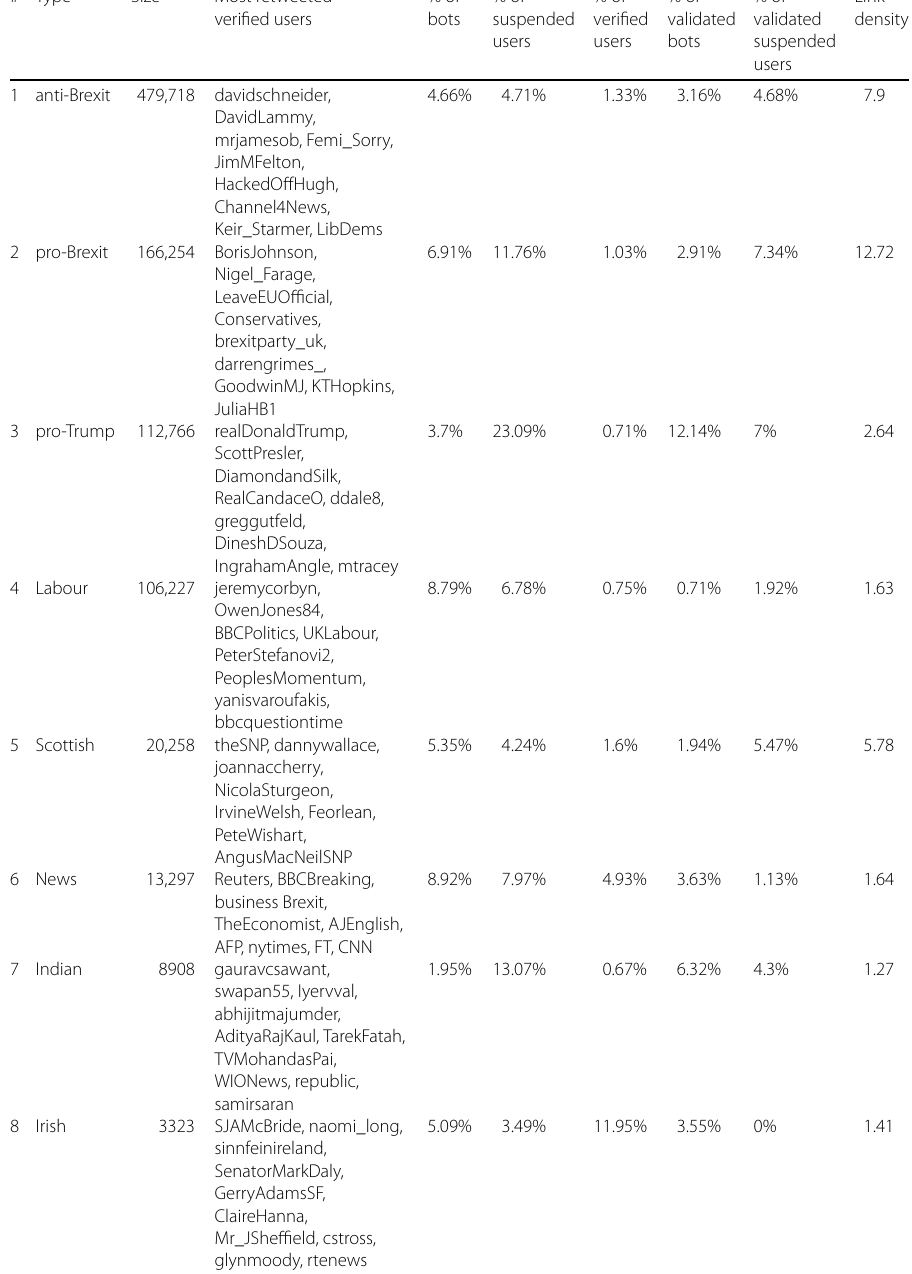
Table 2 Composition of the main discursive communities of the verified-unverified network after the label propagation. The projection on the verified users is shown in Fig. 5: from the projected network, the so-found communities are fixed labels in the verified-unverified bipartite network, and are then assigned to the rest of the users via label propagation. The validated bots % and validated suspended % columns show the percentages of bots and suspended users in the community that share a significant number of commonly retweeted hashtags with other users of the same type and therefore appear in the hashtags-users projections of Fig. 7: the higher these percentages are, the more the automated accounts are